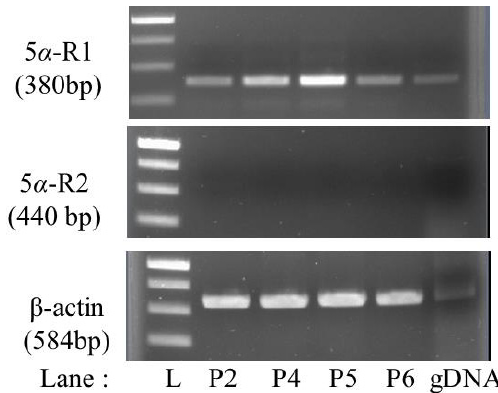
agarose gel showing, from the top, the expression of 5 α -R1 (5 α -reductase type 1, 380 bp), 5 α -R2 (5 α -reductase type 2, 440 bp) and β -actin (584 bp) within passages 2, 4, 5 and 6 of HHDPCs. The 1-kb DNA ladder (L) shows the band sizes of 1 kb and 750, 500 and 250 bp from the top